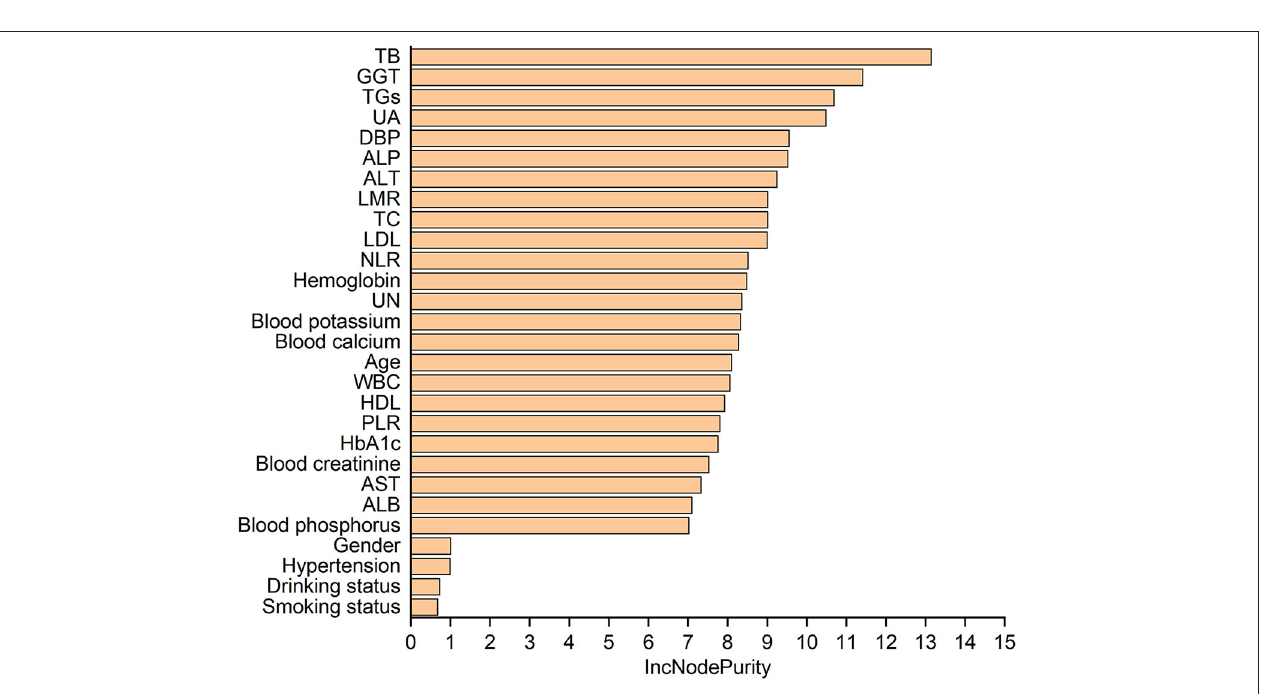
FIGURE 4 | Importance analysis of indexes in RF